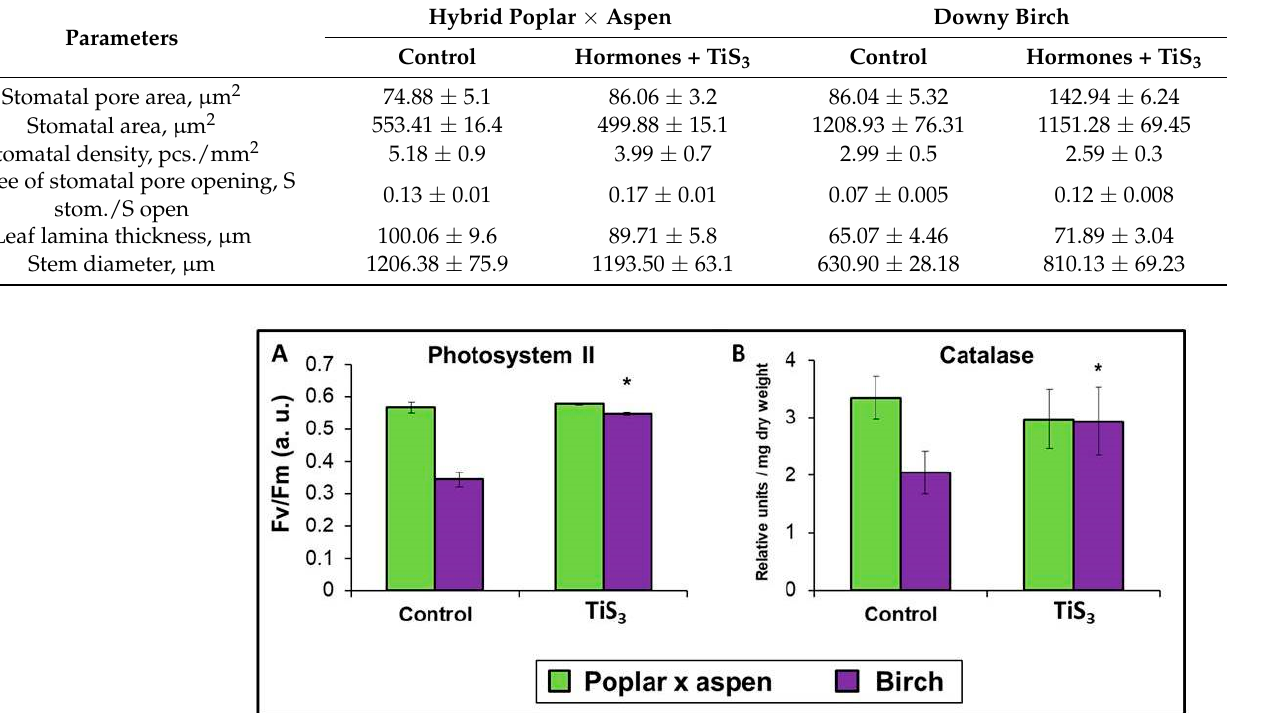
Figure 5. Microclones parameters: ( A ) photosystem II activity, ( B ) catalase activity (* is significant deviation from control).